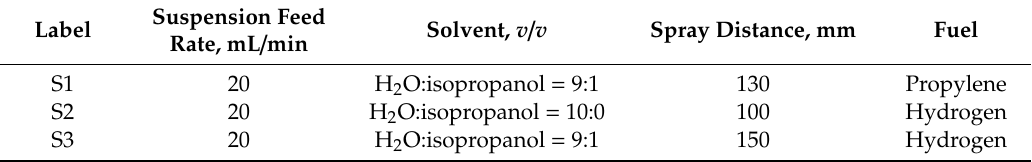
Table 1. Deposition parameters of suspension high velocity oxy-fuel (HVOF) sprayed TiO 2 coatings.